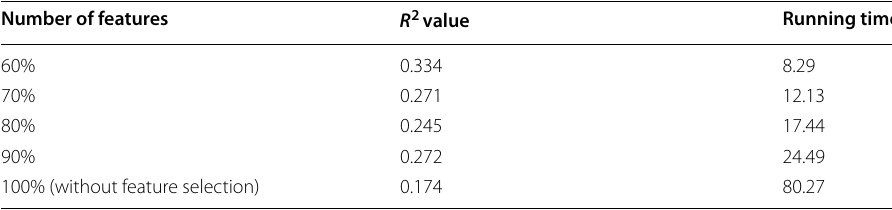
Table 8 QSAR-RFR(SPCA) simulation results on FCFP_4 dataset Number of